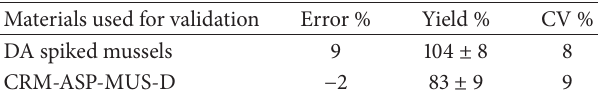
Table 1: Validation parameters of preanalytical method developed in this work for three